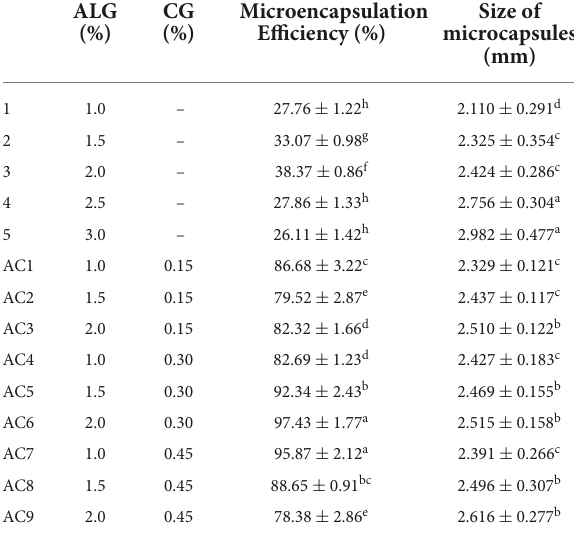
TABLE 1 Encapsulation rate and particle size of microcapsules.